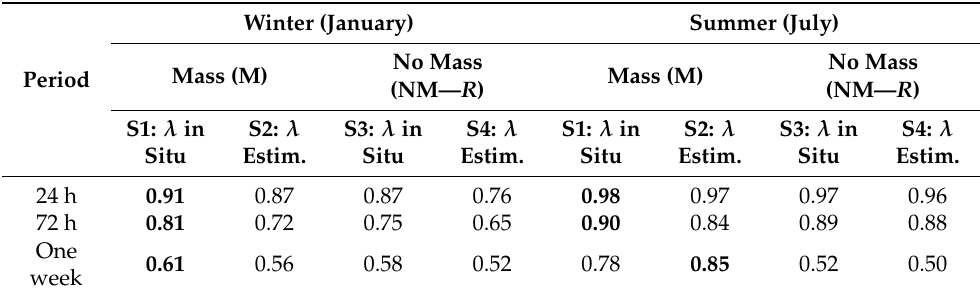
Table 5. R 2 correlation between measured and the simulated dry-bulb temperature in simulations 1 to 4. In bold: simulated values that are closer to the measured temperatures.